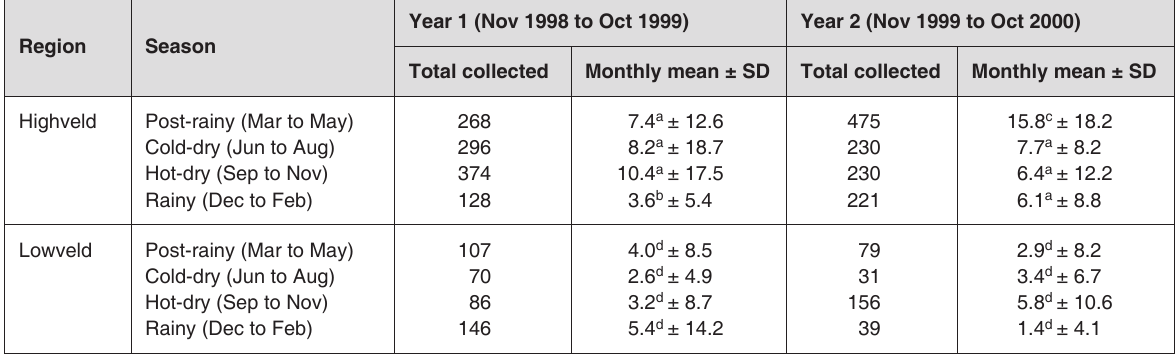
Lowveld Figures with a different superscript within a column or row are significantly different at P < 0.05 SD = Standard deviation TABLE 6 Seasonal distributions of Bulinus globosus in the highveld and lowveld communal grazing areas of Zimbabwe for the period November 1998 to October 2000